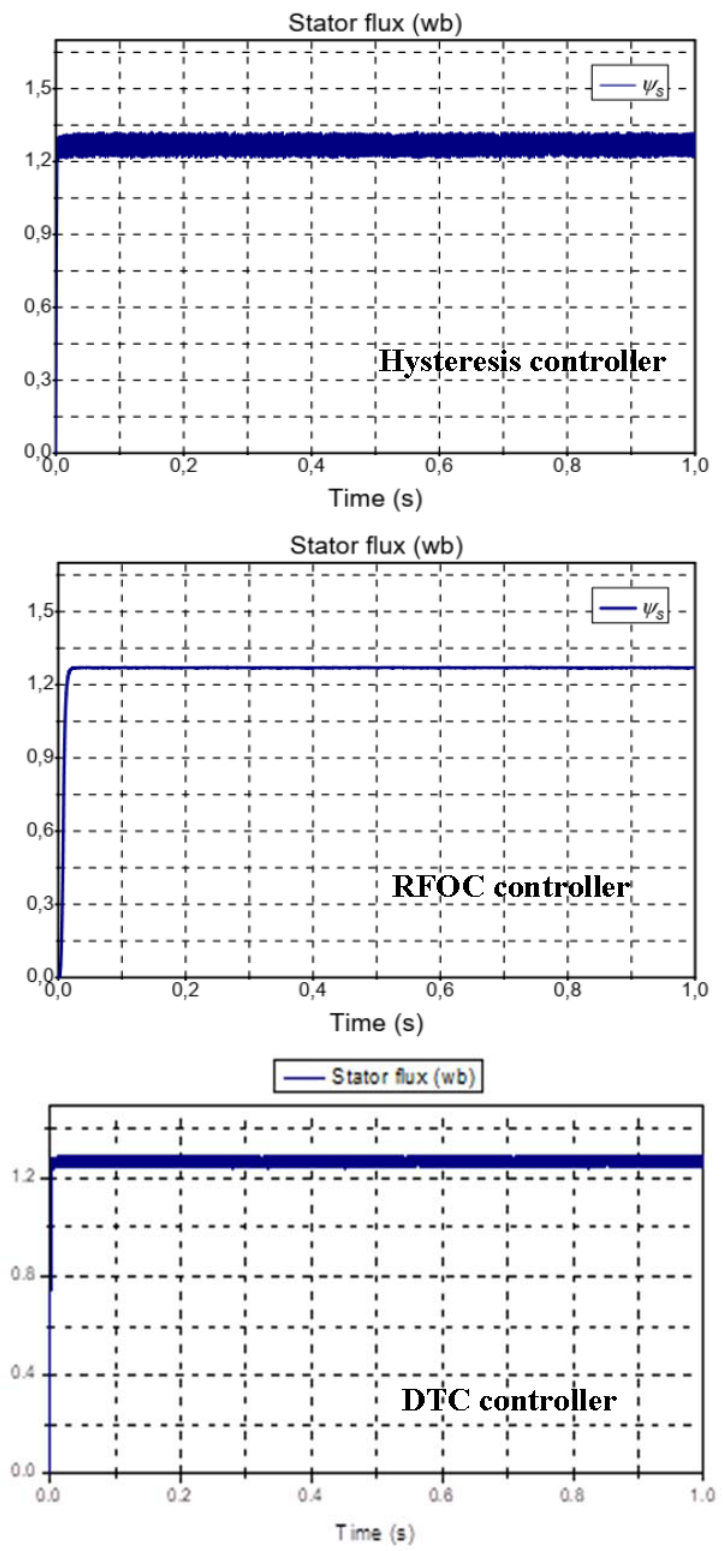
Figure 11. Stator flux performance for the three controllers.